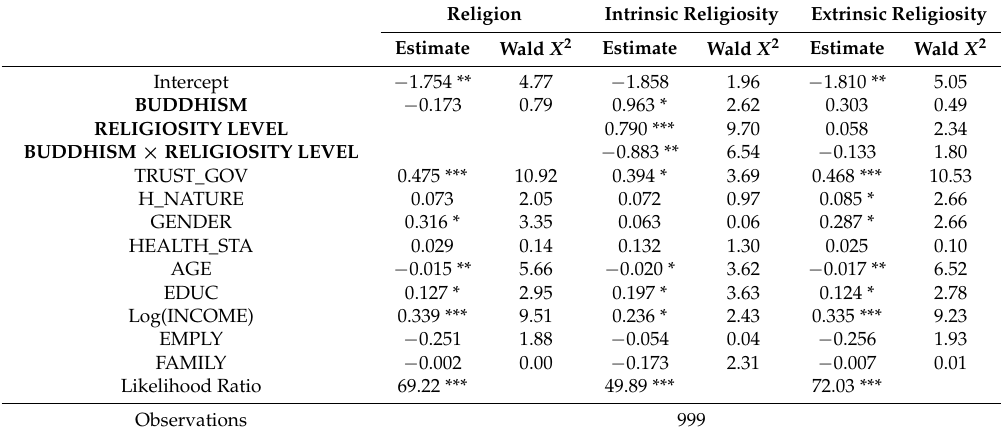
Table 7. The effect of Buddhism and religiosity level on the willingness to donate organ.